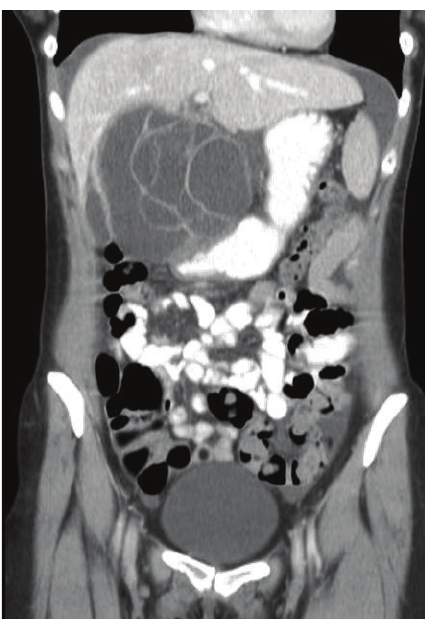
Figure 1: Name of image: CT coronal reformat with intravenous contrast.Description:contrastenhancedCTconfirmedthepresence of a large complex cystic mass. The origin of the mass was in close proximity to the pancreas, liver, and stomach. No biliary or pancreatic duct dilatation was observed on CT.